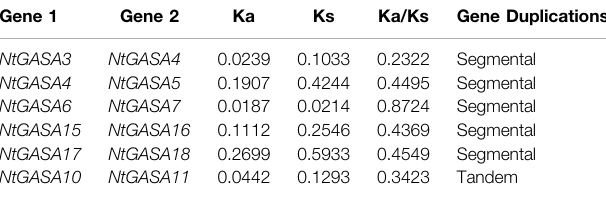
TABLE 3 | Calculation of Ka and Ks ratios of six duplicated NtGASA gene